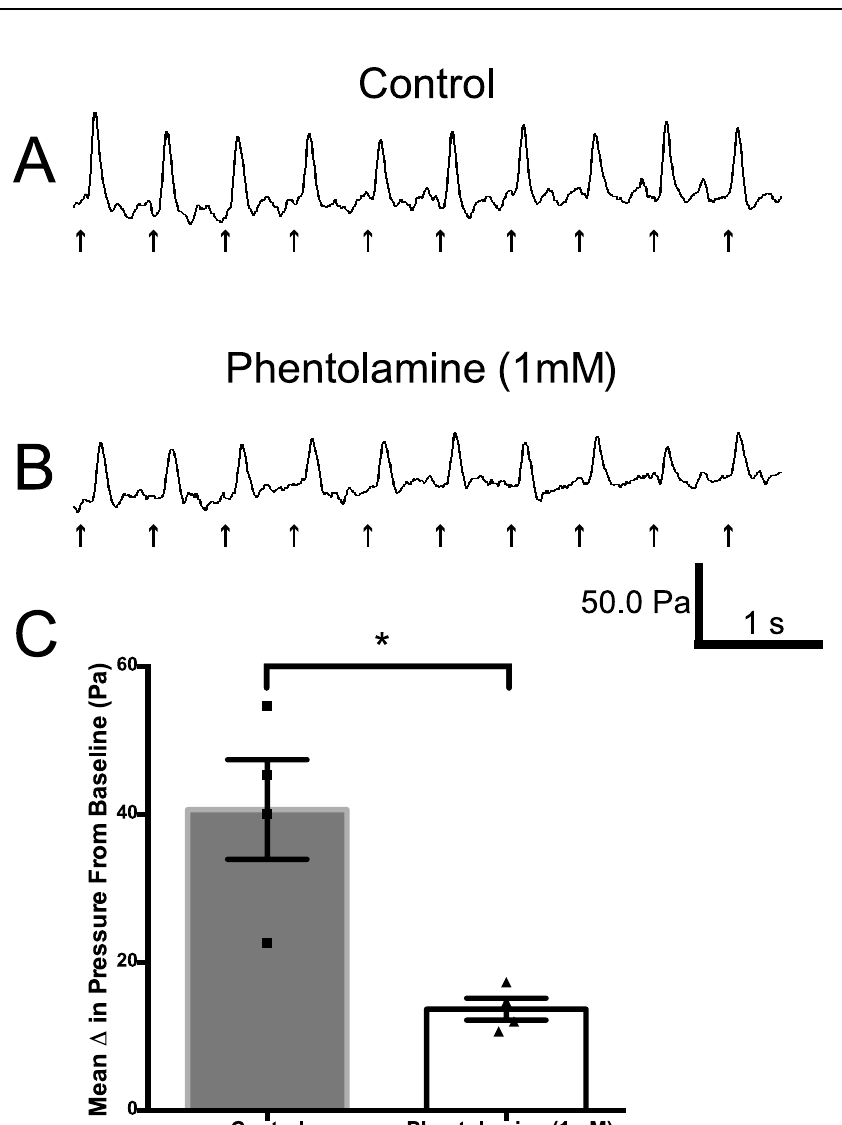
Fig 6. Suppression of electrically evoked aortic contractions by phentolamine. (A) Rhythmic phasic contractions elicited in the aorta by a 5s pulse train (1.7 Hz, 2 msec, 10 volts), the amplitude of which was reduced by topical application of 1 mL of 1 mM phentolamine (B). (C) Graph illustrating the mean change in pressure from baseline induced by electrical stimulation of the aorta in the absence and presence of phentolamine (n = 4). * Significance p <